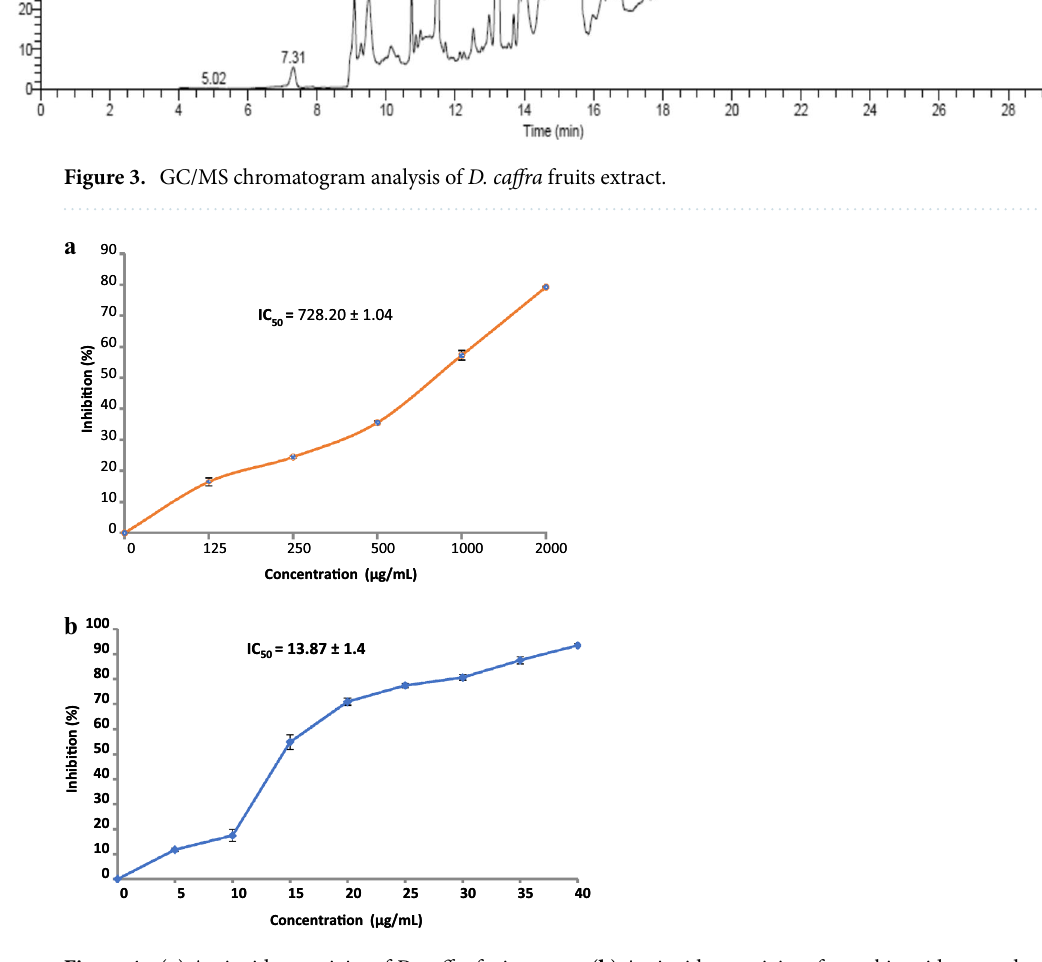
Figure 4. ( a ) Antioxidant activity of D. caffra fruit extract. ( b ) Antioxidant activity of ascorbic acid as standard